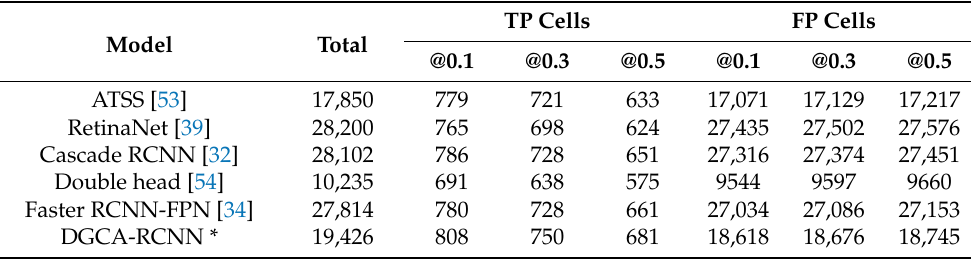
Table 6. Comparison of the true positive and false positive cancerous cell numbers as detected by the different models at three different IOU thresholds.